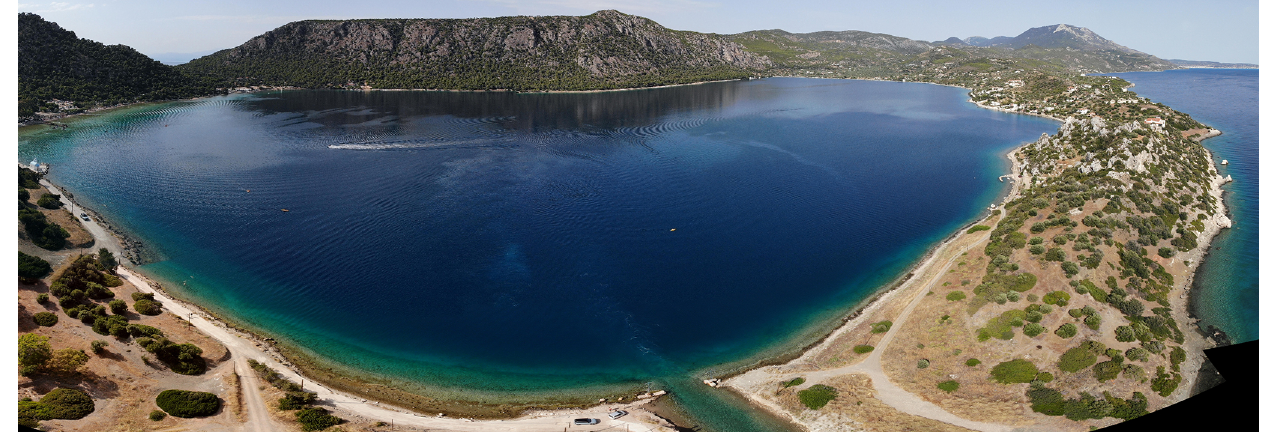
Figure 5. Aerial view of Lake Vouliagmeni, formed as a karst cavity. On the bottom part of the image, the artificial channel is visible, constructed a century ago, connecting the lake with the sea. According to Stiros (1995), the level of the lake corresponded to the sea level, even in